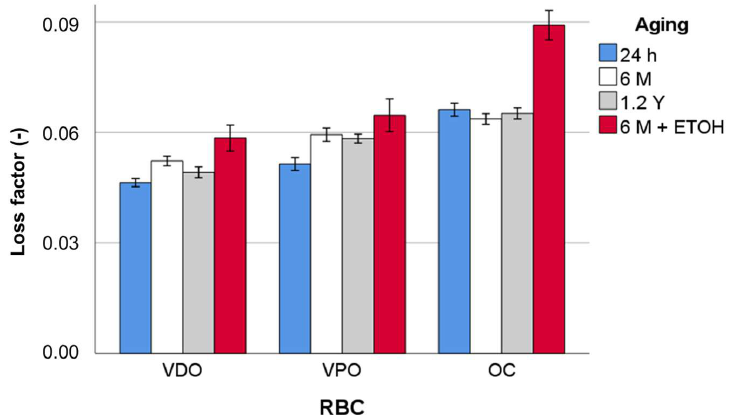
Figure 11. Loss factor (tan δ) as a function of frequency and aging method, exemplified for the ma- terial OC.